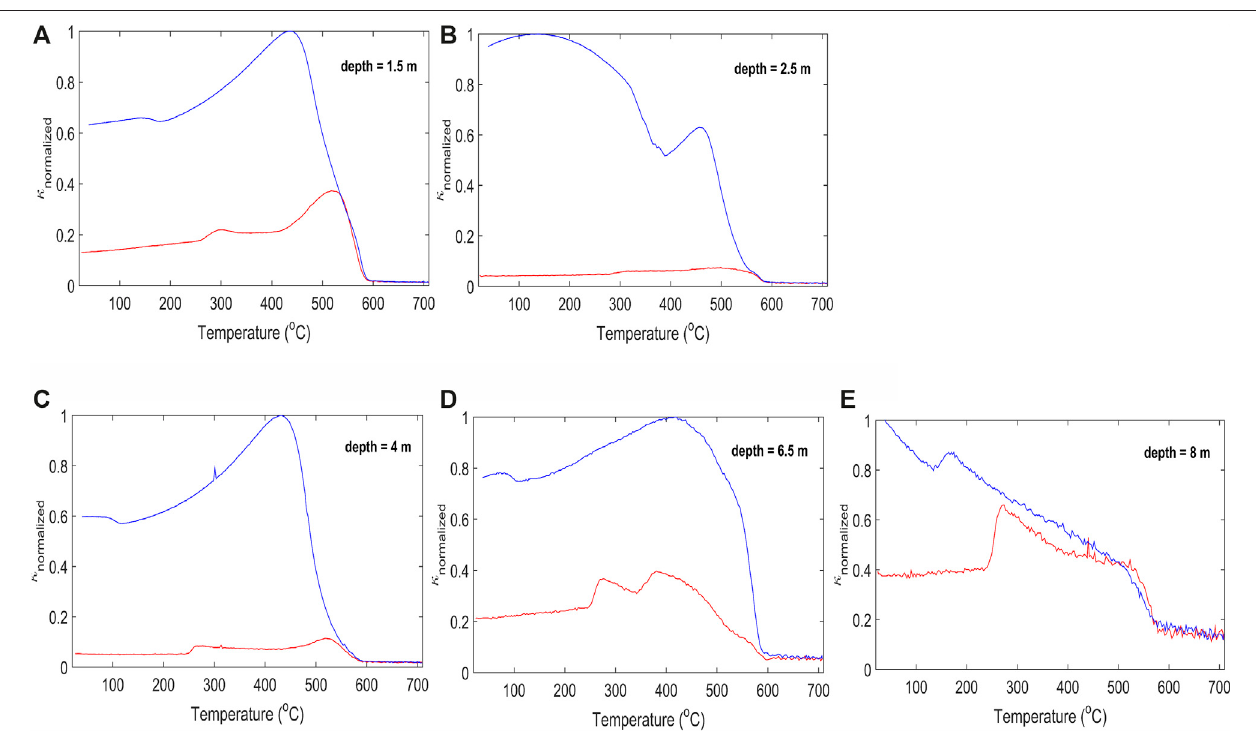
FIGURE2| Magneticsusceptibilitychangeswithtemperatureforsamplescollectedat1.5, 2.5,4,6.5and8 m, duringsampleheating(red) andcooling (blue). The samples are representative of the anthropogenic deposits (A – C) and the Quaternary sediments (organic (D – E) . The different values of susceptibility measured when comparing the heating and cooling curves reveal mineralogical transformations caused by dehydration or change in the sample redox state in the heating process.